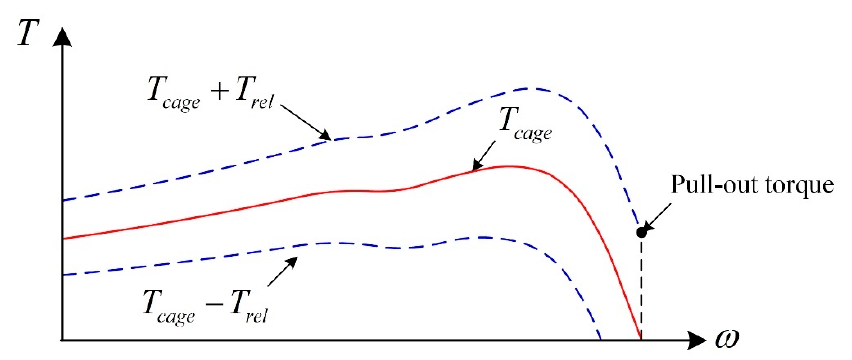
Figure 2. Speed-torque curve of LS-SynRM.